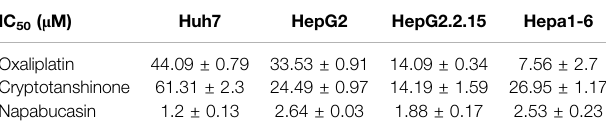
Frontiers in Pharmacology |